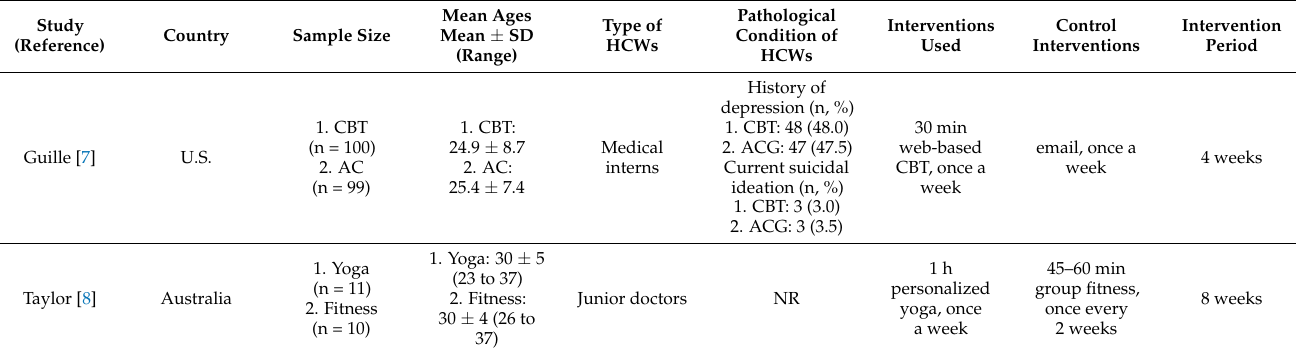
Table 1. Characteristics of included